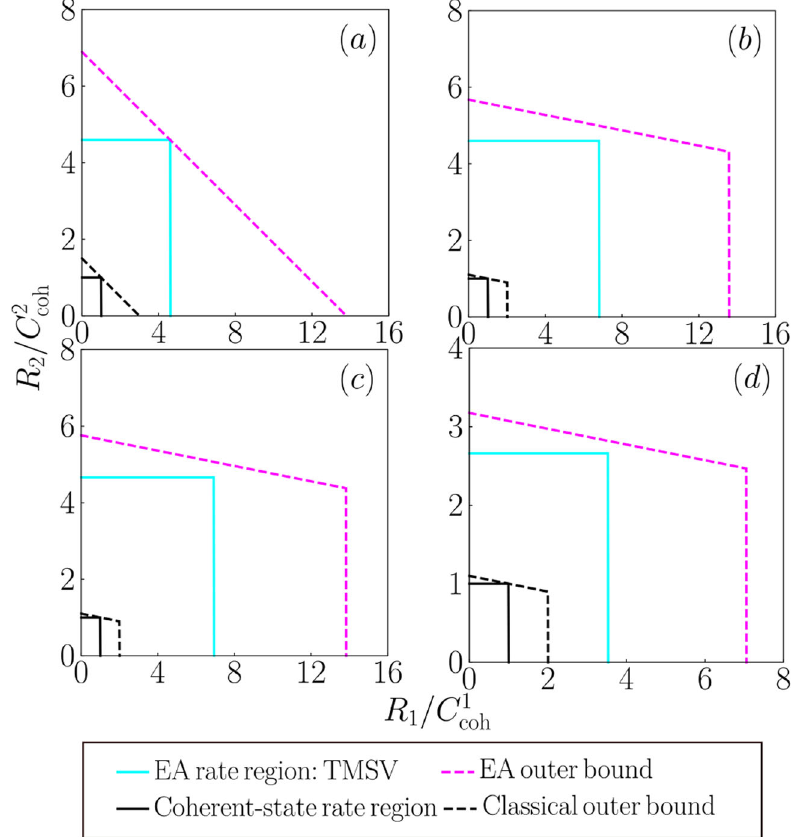
Fig. 4 The two-sender rate region. Rates are normalized by the coherent-state bounds C 1 scenario of: a microwave domain, τ = 0.01, N B = 20, N S,1 = N S,2 = 0.01, η 1 = 1/3, η 2 = 2/3. b microwave domain, τ = 0.01, N B = 20, η 1 = η 2 = 1/2, N S,1 = 0.001, N S,2 = 0.01. c a noisy channel, τ = 10 − 3 , N B = 10 4 , η 1 = η 2 = 1/2, N S,1 = 0.001, N S,2 = 0.01. d long wavelength infrared domain η 1 = = 1/2, τ = 0.001, N = 0.1, N = 0.001, N = 0.01. The EA rate region in Ineq. (4) (cyan solid), evaluated on TMSV states, is bounded by the η 2 B S,1 S,2 EA outer bound (magenta dashed) in Ineqs. (11) and (10); while the coherent-state rate region (black solid) given by Ineq. (8) is bounded by the classical outer bound (black